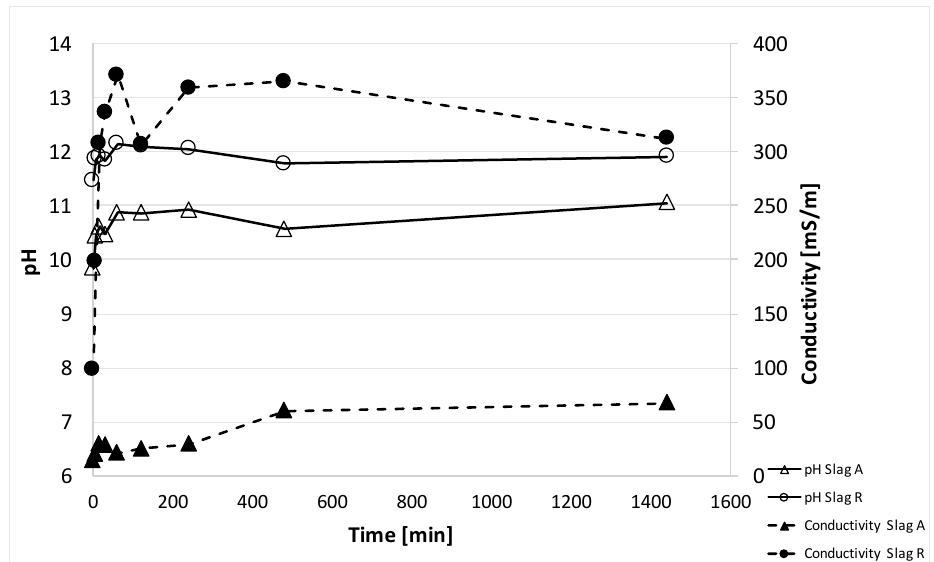
Figure 3. pH and ionic conductivity values of Slag A and Slag R (lines are drawn for eye help, only). The confidence interval for pH is about 1%, while for conductivity is around 2%.